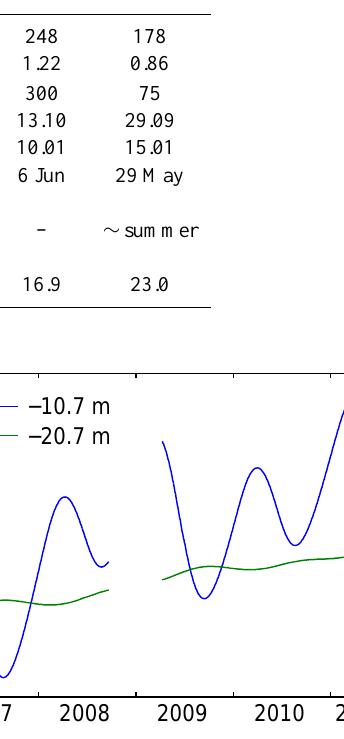
Fig. 11. Daily mean temperatures at depth in permafrost, 2006– 2011. Data from deep borehole, Samoylov